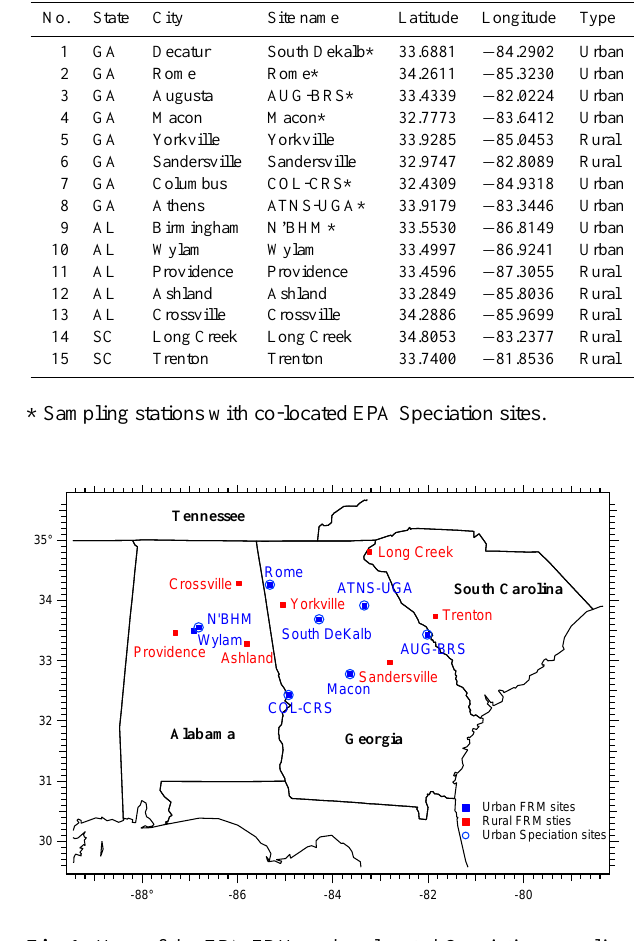
Fig. 1. A subset of all field samples corresponding to a one- in-six-day sampling schedule produced 60 filters for analysis per site and a total of 900 filters. In addition to these filters, a series of field blanks (36 filters) and replicated filters (43 fil- ters) were included for quality